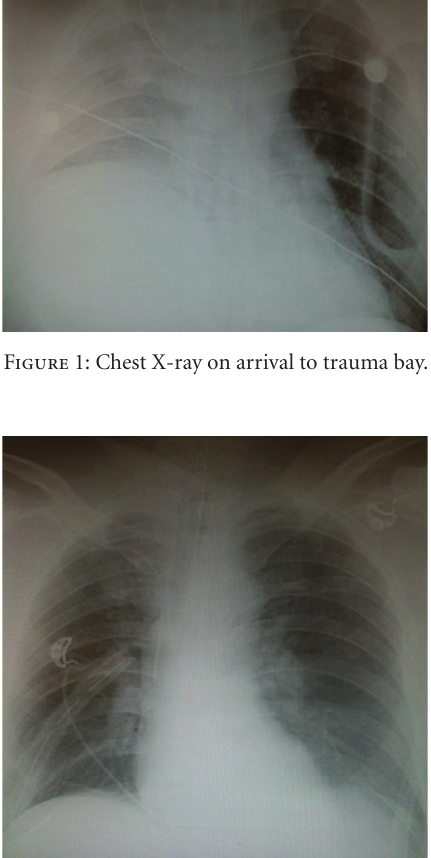
the operation, computed tomography scan (CT) revealed a subarachnoid hemorrhage, C2 vertebral body fracture,